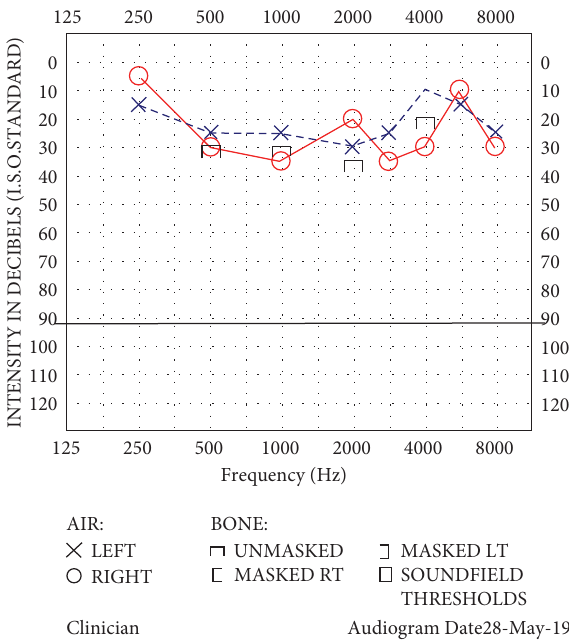
Figure 2: Audiogram posttreatment: mild sensorineural hearing loss (right greater than the left).